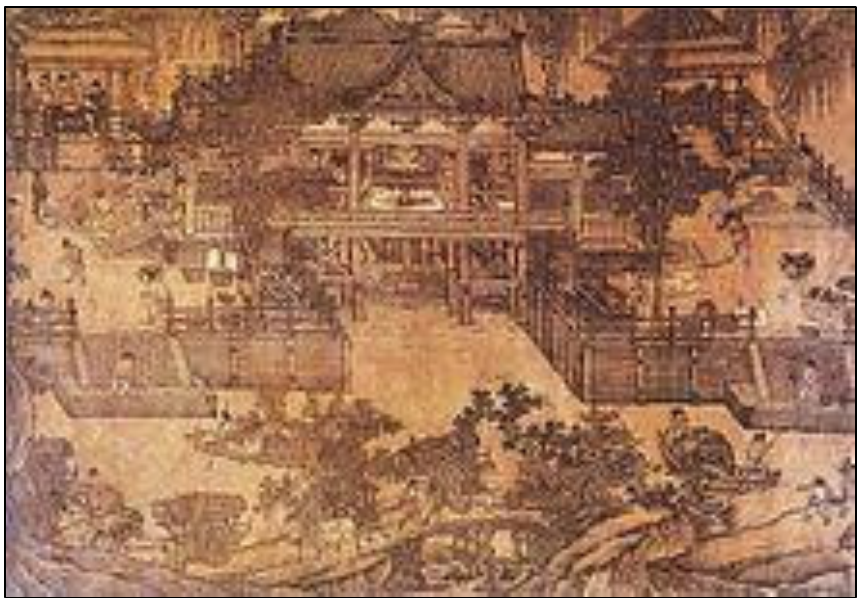
Figure 6. A northern Song era (960–1127 AD) water-powered mill for dehiscing grain with a horizontal wheel (adapted from [23]).